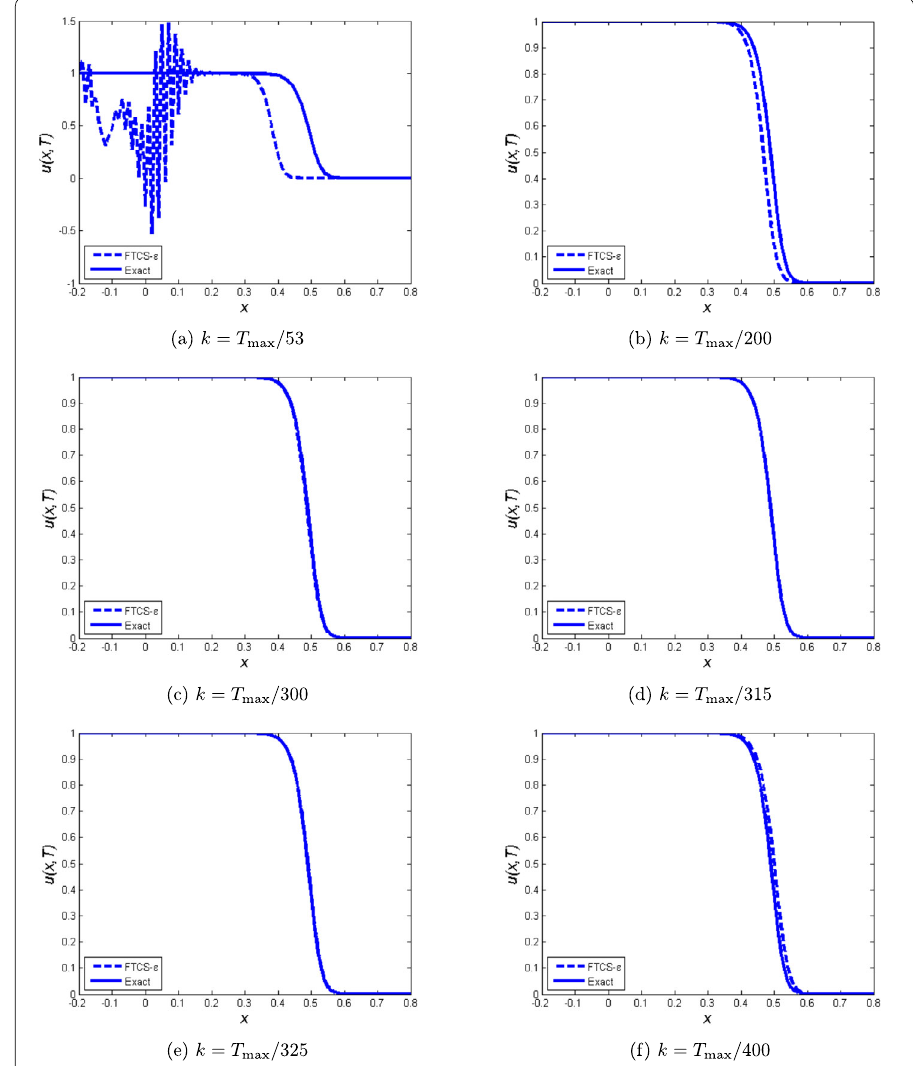
Figure 2 Plot of u against x for Problem 1 using FTCS- (cid:5) scheme at time 2.5 × 10 –3 and some different values of k and h = 0.01, (cid:5) = 0.01, T max = 2.5 × 10